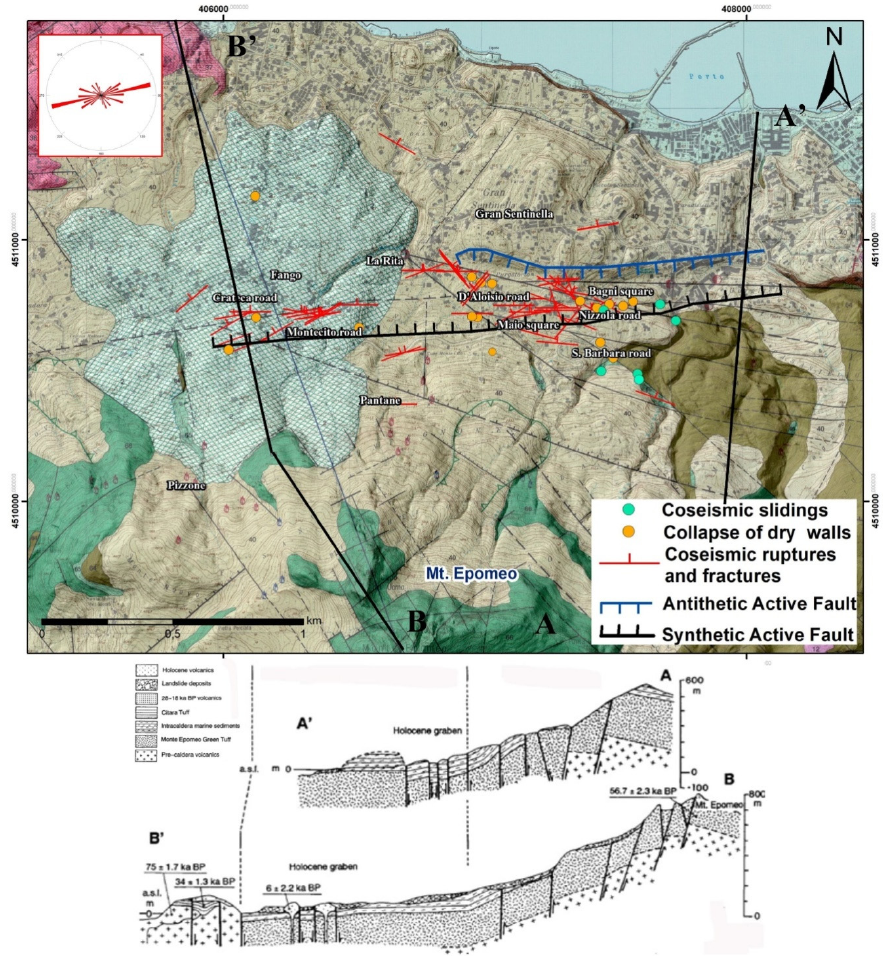
Figure 2. Top, map of the coseismic ruptures, secondary environmental effects and collapse of drywall (data reported because located in the immediate vicinity of ground effects) in the epicentral area of the 21 August 2017, earthquake [4], overlapped on the geological map of [16]; black line is the synthetic active fault and blu line is the antithetic Holocene normal fault scarps of the Casamicciola Terme graben (ticks mark the downthrown side); bottom, geological cross-sections of the epicentral area, with structural details of the Holocene graben [9], trace location on the top.